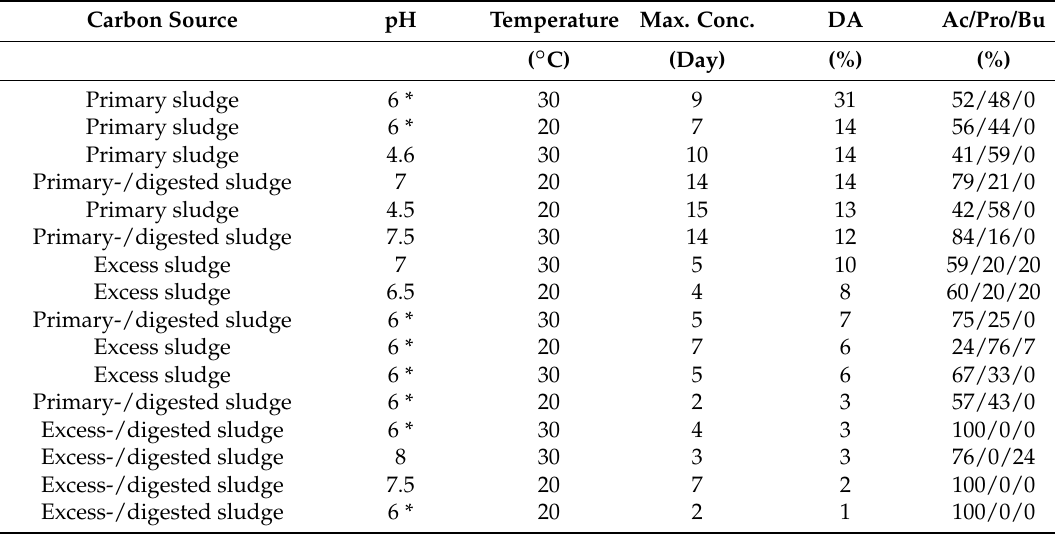
Table 2. Degree of acidification and VFA composition in dependence of substrate and operation conditions (batch-tests, 4